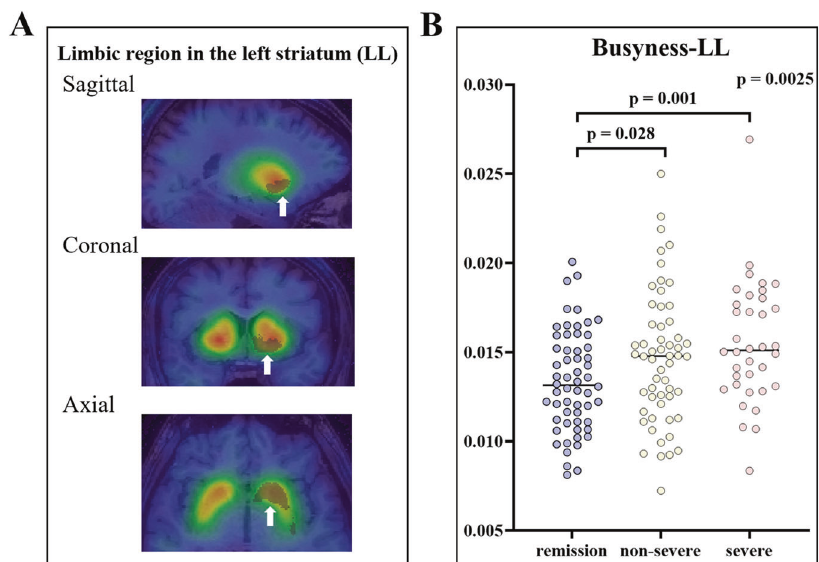
Fig. 2 Busyness-LL and the severity of depression. A ROI of the limbic region in the left striatum superimposed on MR and SPCET images of a subject. Arrows indicate the ROI. B The degree of busyness-LL linked to the severity of depression. LL limbic region in the left striatum, ROI region of interest, MR magnetic resonance, SPECTs single-photon emission computed tomography.